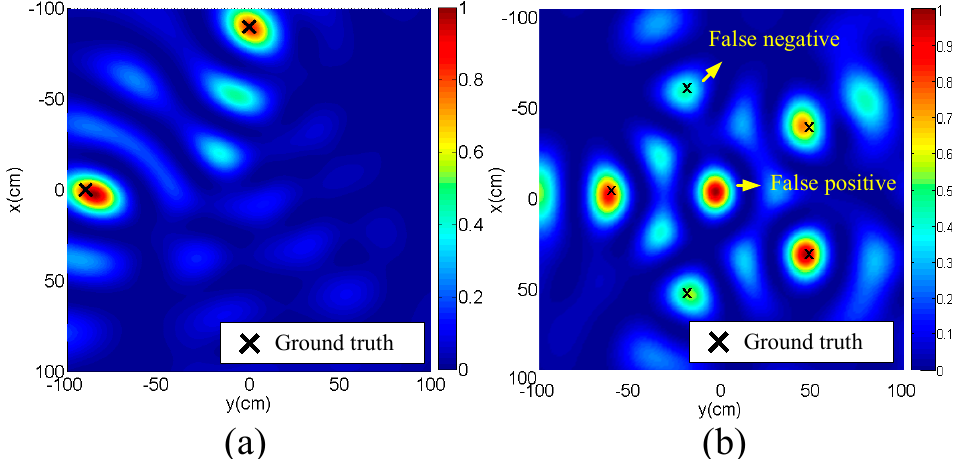
Figure 6. The spatial spectrum after cancelling aperture limitation and mutual coupling: ( a ) two targets and ( b ) five targets.